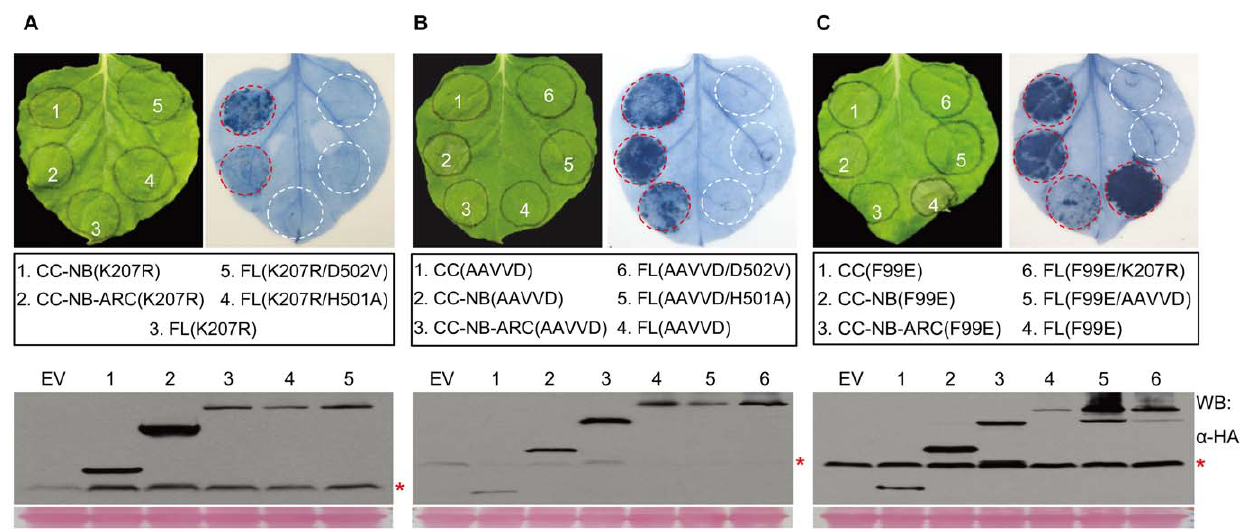
Figure 4. Tightly regulated MLA10 cell death inducing activity. ( A ) Analysis of cell death triggering activity of MLA10 variants harboring the K207R P-loop mutation. The indicated N-terminal MLA10 fragments containing the K207R mutation, or FL variants harboring K207R alone or K207R combined with an MHD mutation (H501, D502V), were expressed in N. benthamiana leaves by Agro-infiltration. Cell death triggered by each fusion was assessed by trypan blue staining at 42 hpi (upper panel). Protein expression levels of indicated MLA10 mutant fragments are shown (lower panel). Proteins were extracted at 40 hpi and detection was done by immunoblotting with anti-HA antibody. ( B ) Analysis of cell death activity of MLA10 variants harboring mutations in the EDVID motif. The EDVID motif (EDVVD in MLA10) was mutated to AAVVD, and the indicated MLA10 fragments or FL variants harboring indicated mutation(s) were expressed in N. benthamiana leaves by Agro-infiltration. Cell death triggered by each variant was assessed by trypan blue staining at 42 hpi (upper panel). Protein expression levels of indicated MLA10 mutant fragments are shown (lower panel). Proteins were extracted at 40 hpi and detection was done by immunoblotting with anti-HA antibody. ( C ) Analysis of cell death activity of F99E containing MLA10 fragments or FL variants. Indicated MLA10 fragments or FL variants harboring indicated mutation(s) were expressed in N. benthamiana leaves by Agro-infiltration. Cell death triggered by each protein was scored by trypan blue staining at 42 hpi (upper panel); Protein were extracts from N. benthamiana leaves and subjected to immunoblotting with anti-HA antibody (lower